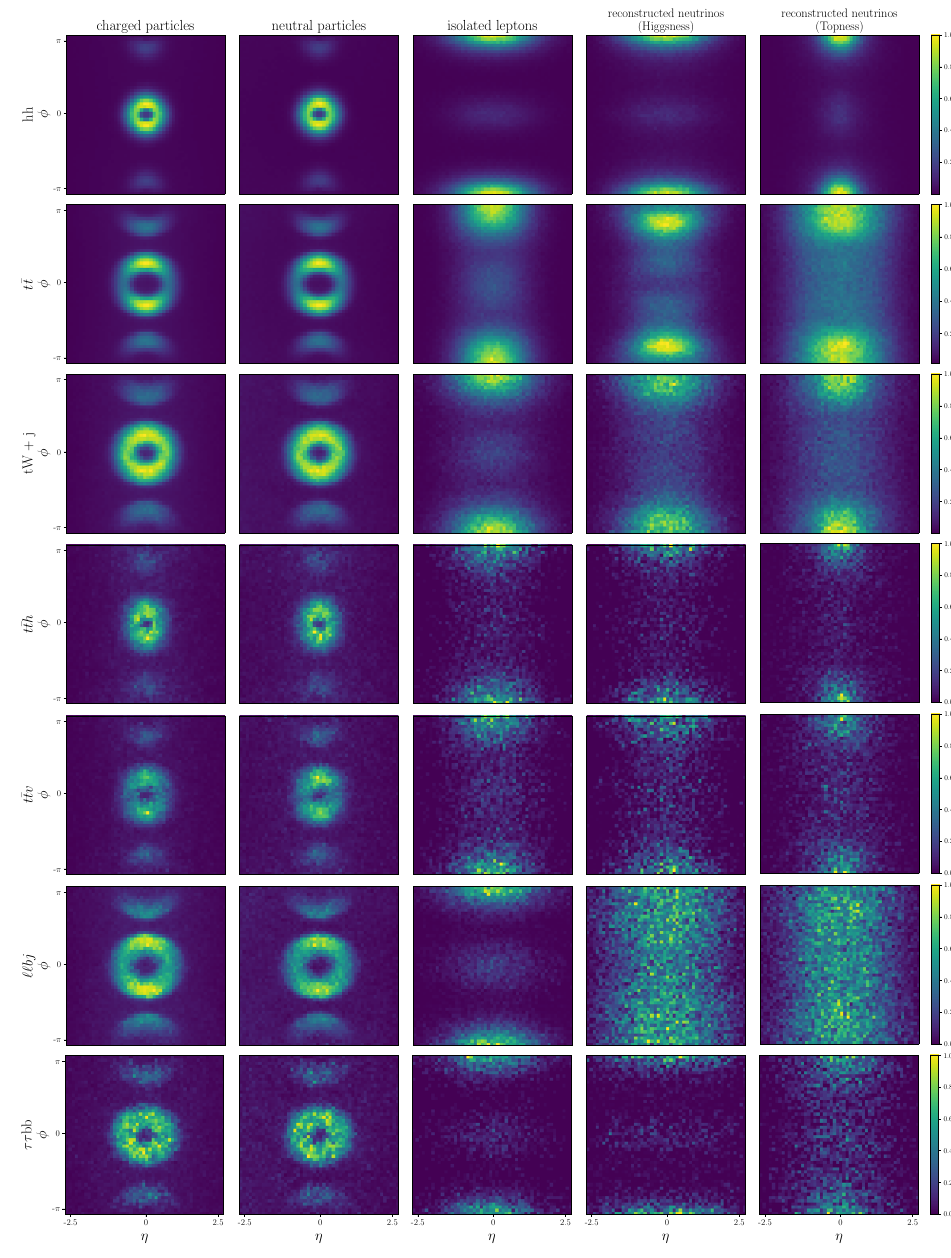
Figure 1 . The cumulative average of various particle images for the signal and the different background processes after the baseline selection. The particles images are shown in the order from left to right: charged hadrons (1st column), neutral hadrons (2nd), isolated leptons (3rd), reconstructed neutrinos using Higgsness (4th), and reconstructed neutrinos using Topness (5th) for the signal ( hh in the first row), t ¯ t (2nd), tW + j (3rd), t ¯ th (4th), t ¯ tV (5th), ‘‘bj (6th), and ττbb (7th). The origin of the ( η, φ ) is taken to be the center of the reconstructed two b -tagged